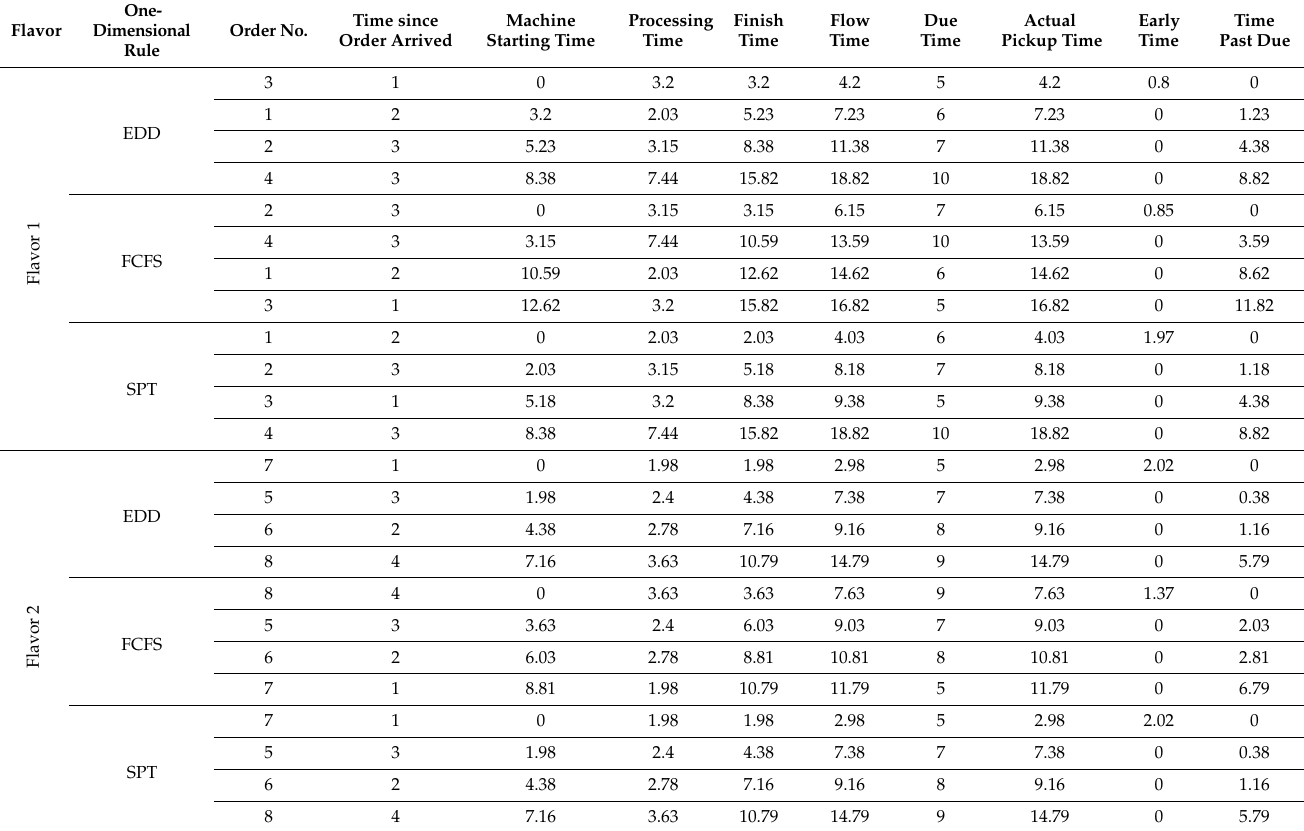
Table 4. The processing of bottles based on different one-dimensional